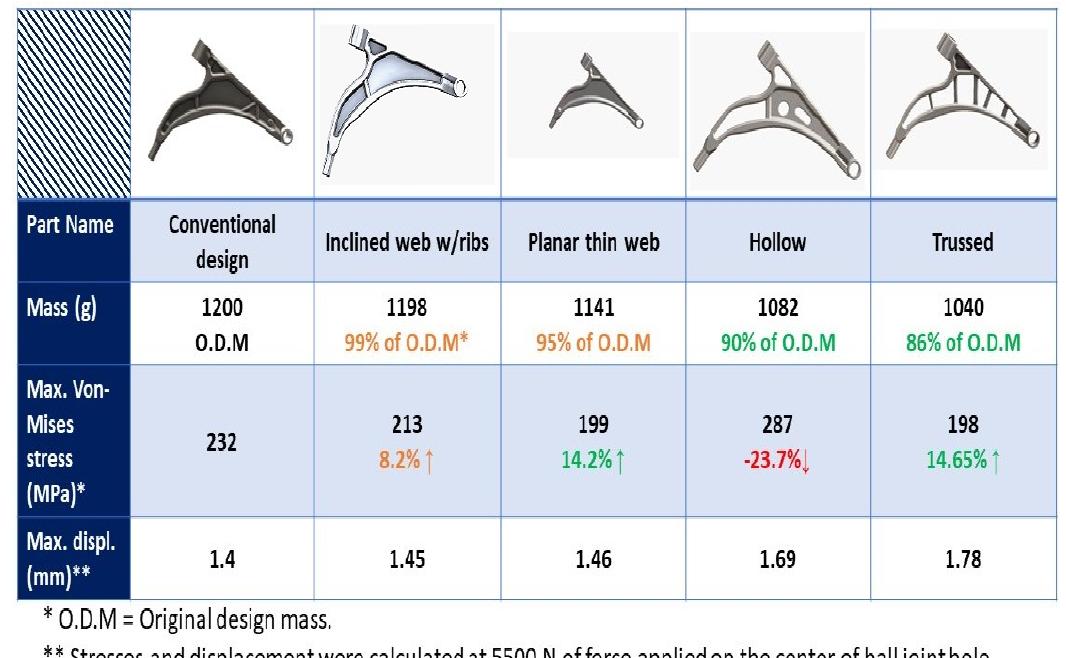
Figure 11. Finite element (FEA) results obtained for the applicable parts with various designs